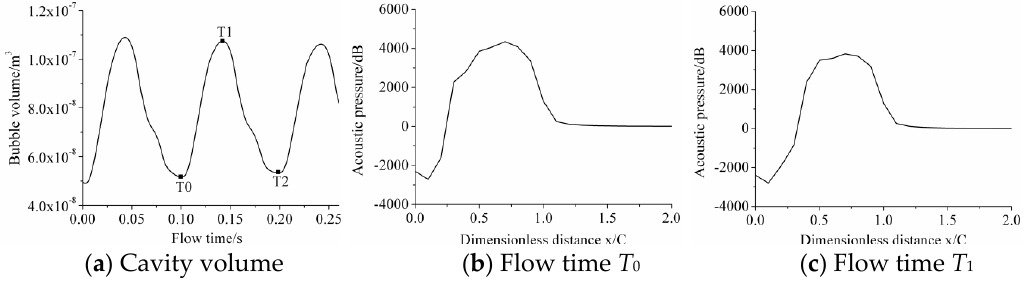
Figure 5. Acoustic pressure at different flow times for σ = 1.075.